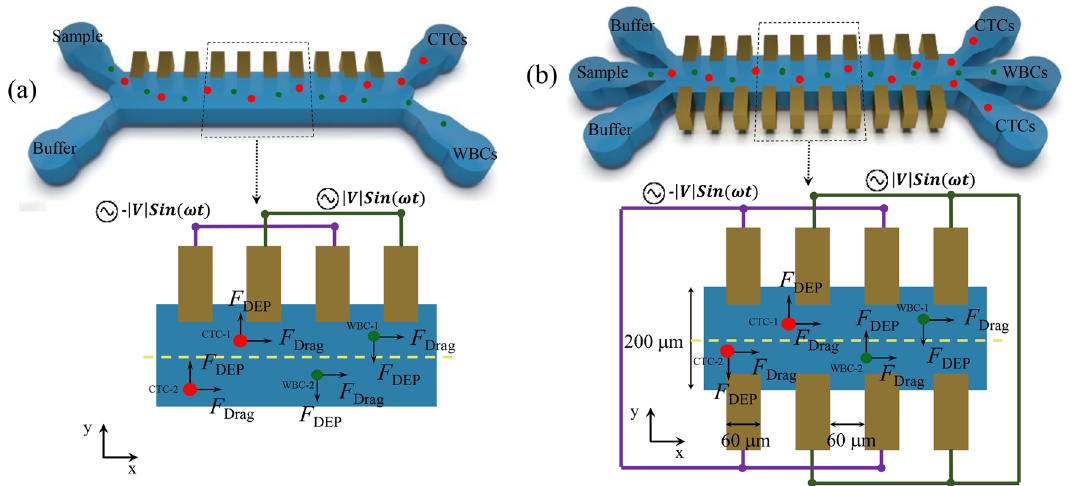
Figure 1. Schematic view of the ( a ) conventional DEP-based systems ( b ) proposed cell separation system. Electrodes are excited by sinusoidal voltages with a 180° phase difference to apply DEP force on